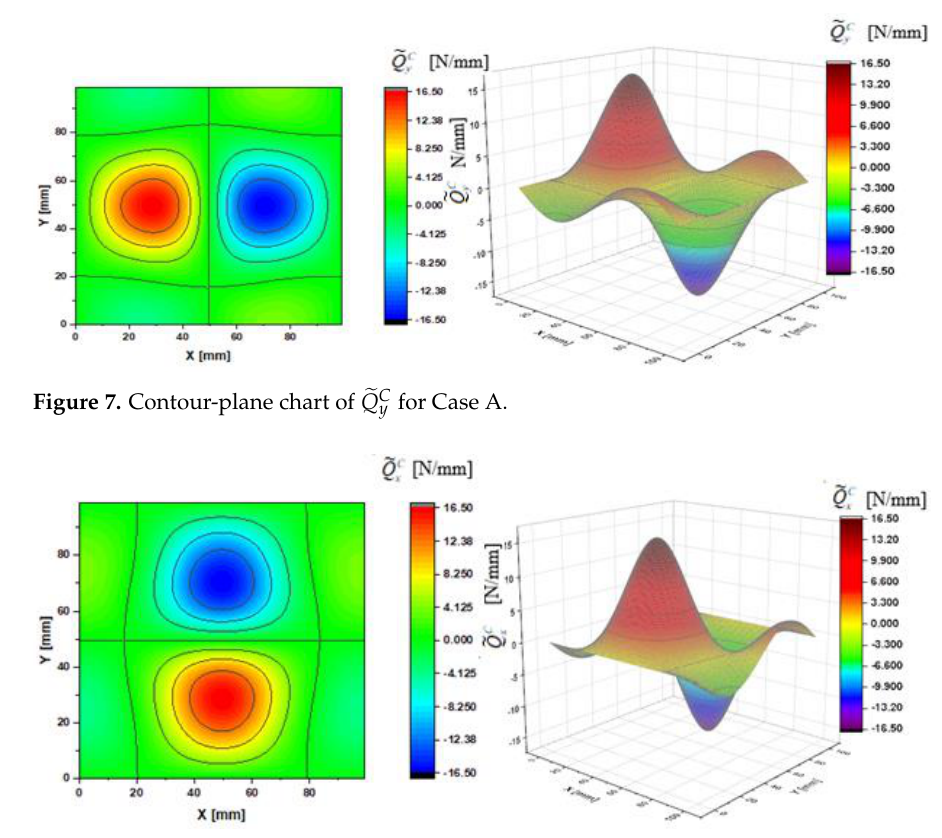
Figure 8. Contour-plane chart of (cid:101) Q C x for Case